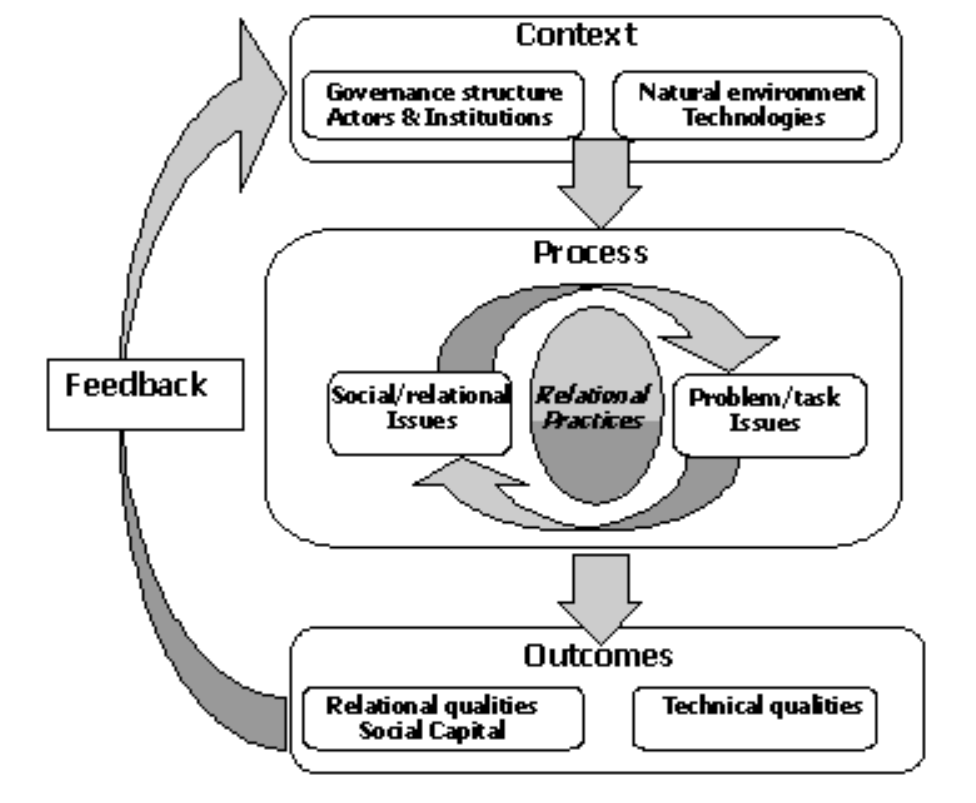
Fig. 1 . Conceptual framework for social learning in resources management. In the center are multiparty processes that are influenced by the context in which they are embedded and produce outcomes that may lead to changes in the context and thus to a cyclic and iterative process of